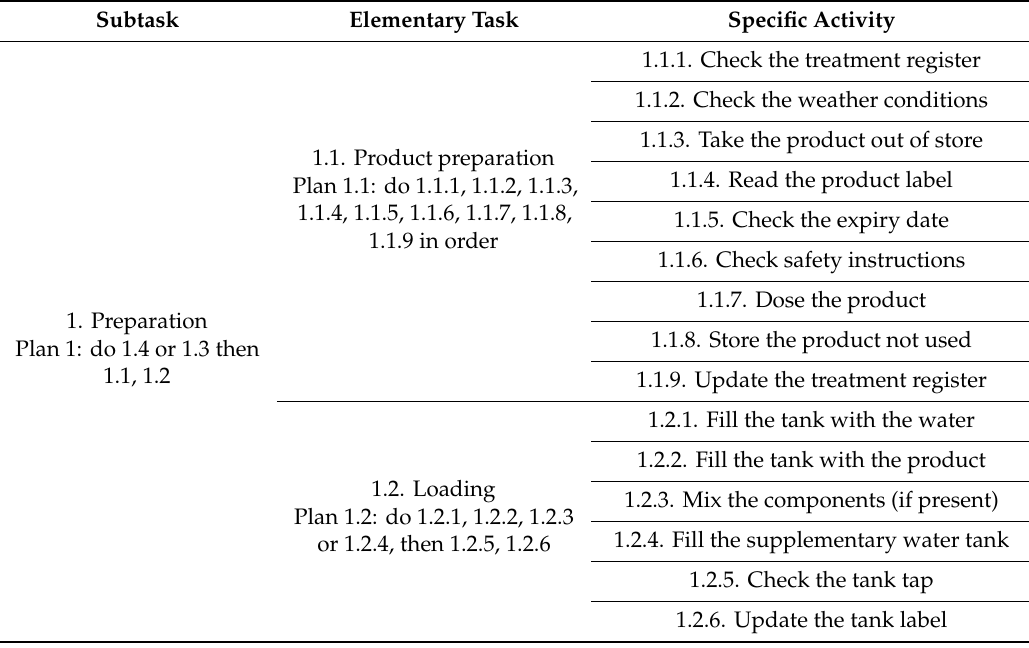
Table 3. Excerpt of the hierarchical decomposition in the list of sub-tasks, elementary tasks and specific activities.